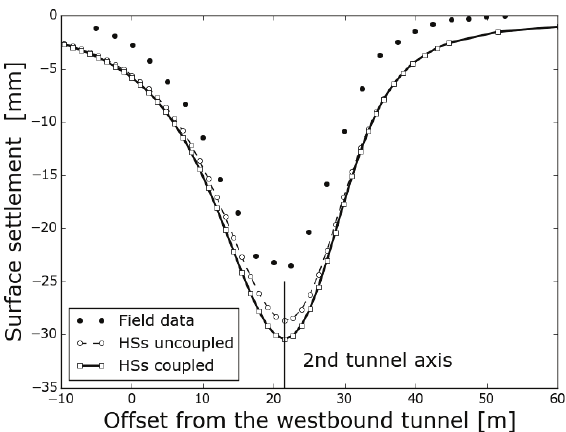
Fig. 8. Surface settlements above the eastbound tunnel after its excavation: field data vs. comparison of uncoupled and coupled